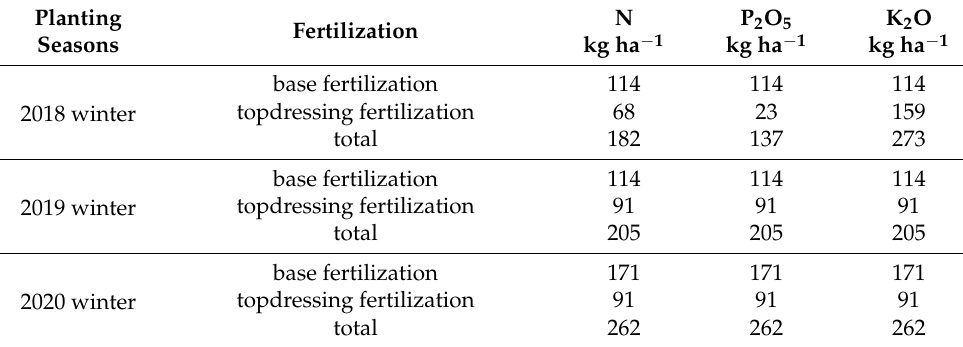
Table 1. Fertilization amounts for three winter seasons.